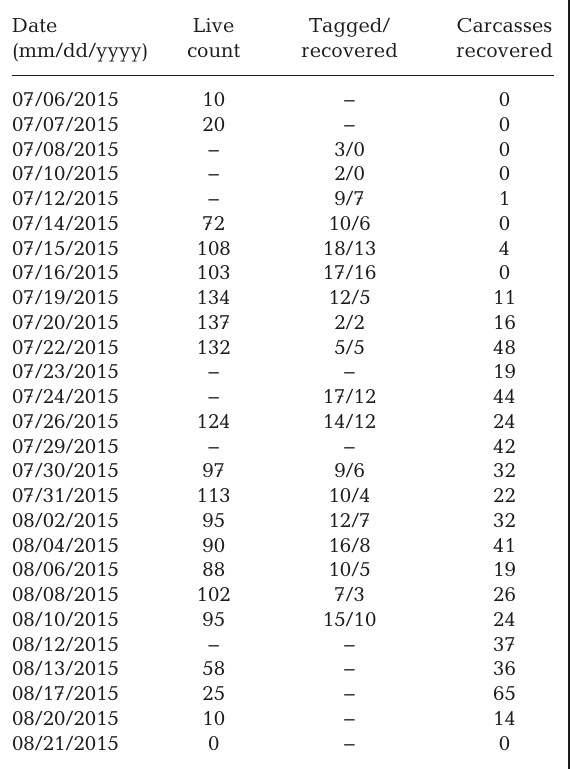
Table 1. Run timing, tagging effort, and carcass recoveries during the 2015 chum salmon spawning season. Live count: number of live chum salmon observed within Sawmill Creek on that date; tagged/recovered: number of fish tagged on that date and the number of deployed tags from that sample day that were eventually recovered later in the season; car- casses recovered: number of both tagged and untagged car- casses (for which origin was positively identified) sampled on date of visit. (−) dates Sawmill Creek was visited but counts or tagging did not occur; non-sequential dates indi- cate which days Sawmill Creek was not